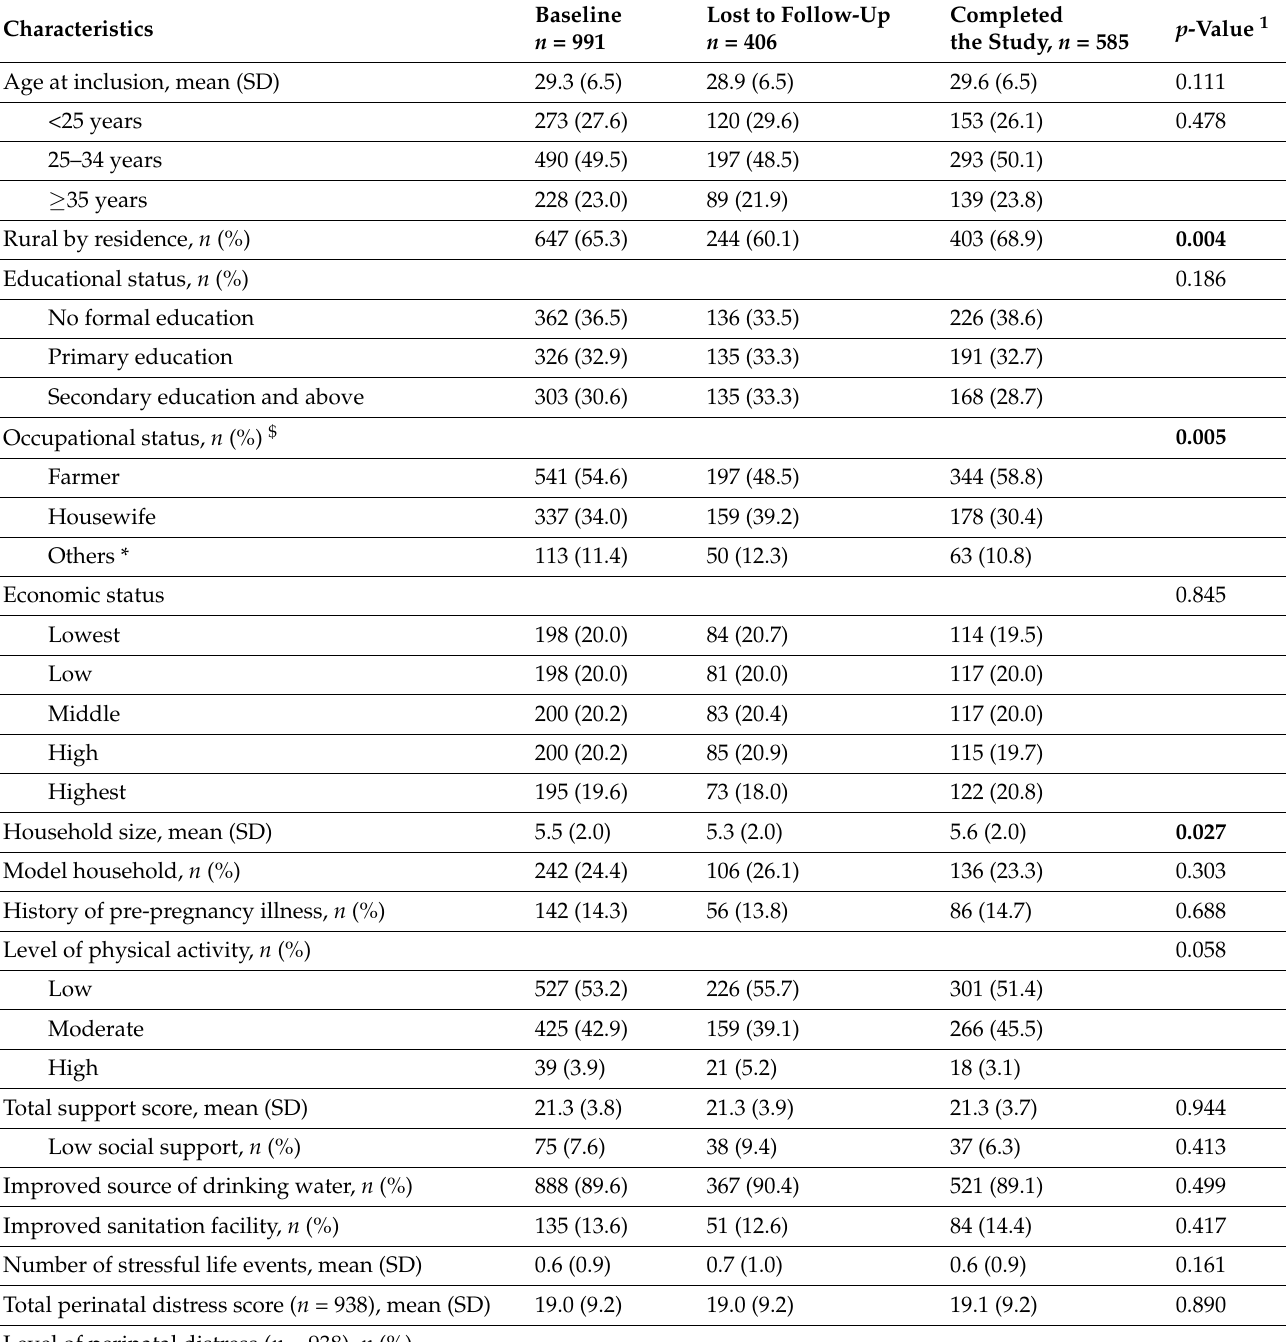
Table 1. Socio-demographic factors, reproductive and obstetric conditions, food and dietary habits, and psychosocial